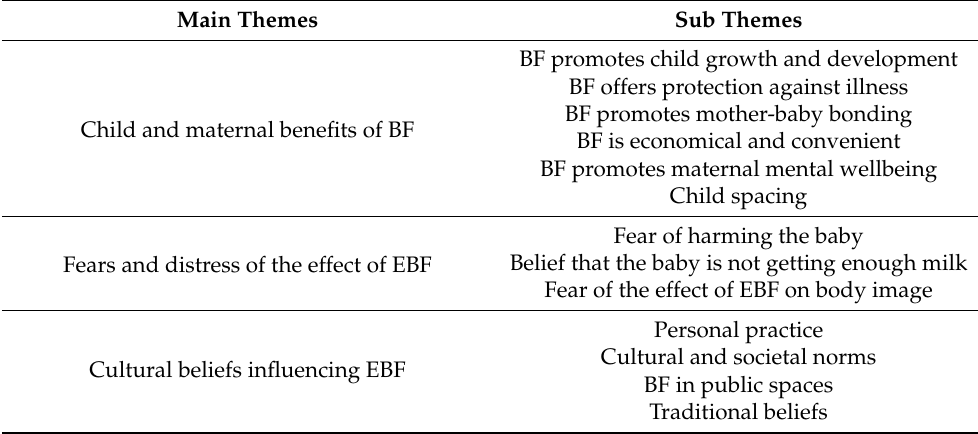
Table 3. Emergent themes from FGDs and